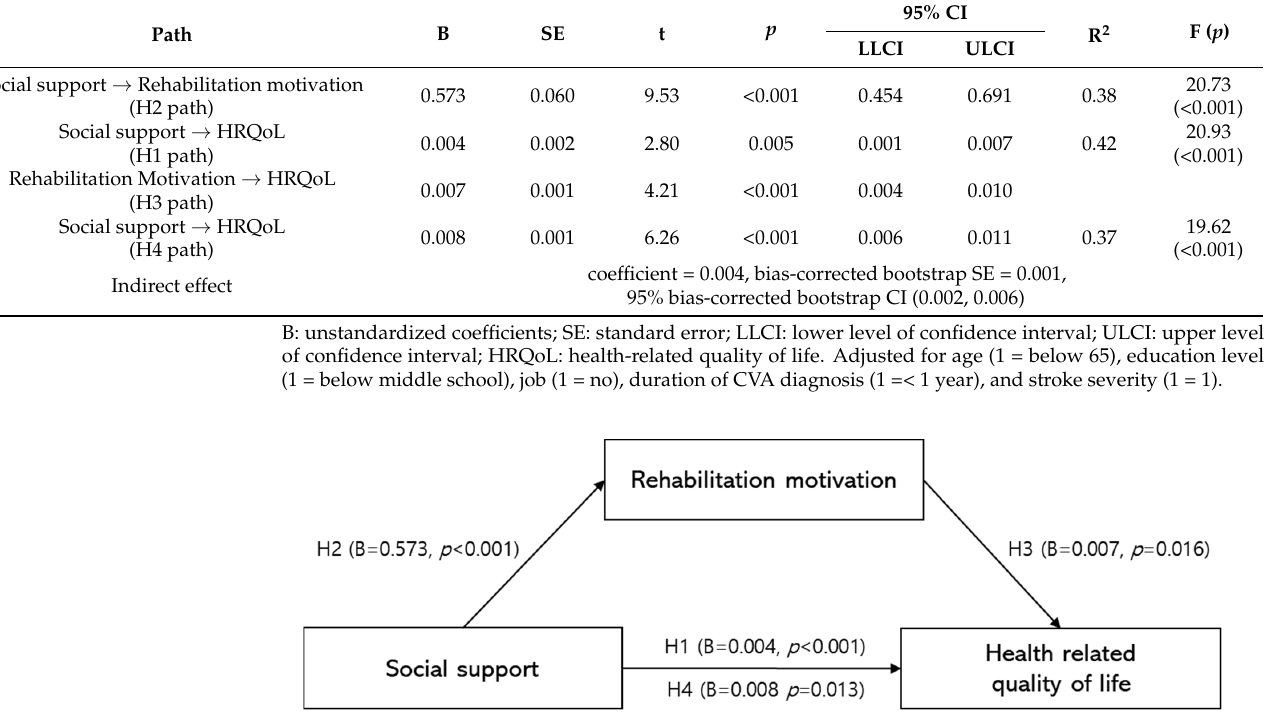
Table 3. Mediating effect of rehabilitation motivation on the relationship between social support and health-related quality of life ( n = 174).